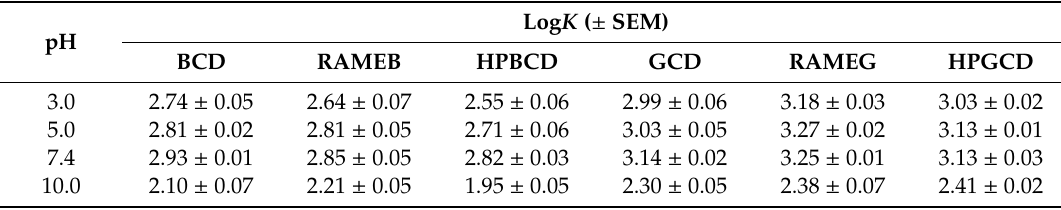
Figure 6. Benesi-Hildebrand plots of Z14G-CD complexes in di ff erent bu ff ers (0.05 M sodium phosphate, pH 3.0; 0.05 M sodium acetate, pH 5.0; 0.05 M sodium phosphate, pH 7.4; 0.05 M sodium borate, pH 10.0; λ ex = 315 nm, λ em = 455 nm). Table 2. Decimal logarithmic values of binding constants ( K ; unit: L / mol) of Z14G-CD complexes in di ff erent bu ff ers.